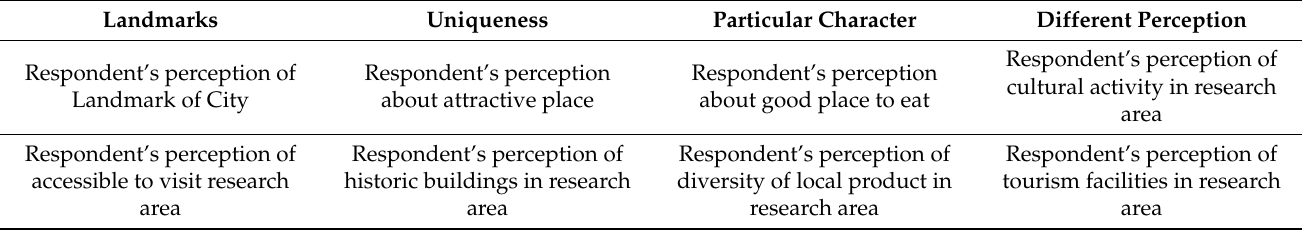
Table 2. Description of local distinctiveness elements (Ginting and Wahid 2017, p.